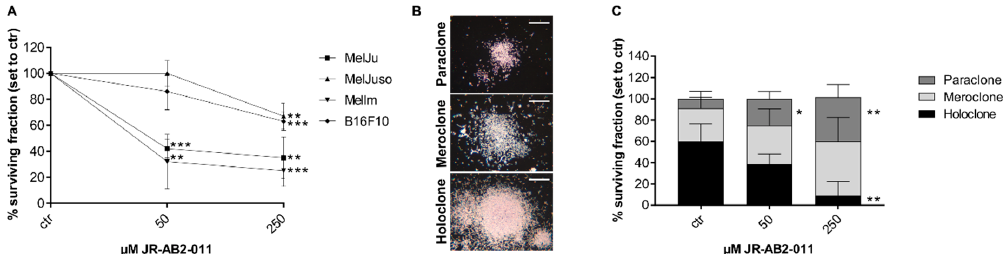
Figure 3. Inhibition of mTORC2 reduced surviving fraction and colony-forming ability. Treatment with JR-AB2-011 (50–250 µM) for 48 h decreased the colony-forming ability significantly in melanoma cells over two weeks in a dose-dependent manner ( p < 0.002) ( A ). Representative images ( B ) show the characteristic morphology of the para-, mero- and holoclones of MelJu. The morphology of the colonies of MelJu altered significantly from the large and rapidly growing holoclone to more miscellaneous meroclones and the small and terminal paraclones in a dose-dependent manner ( p < 0.04) ( C ). Asterisks (* p ≤ 0.05, ** p ≤ 0.01, *** p ≤ 0.001) indicate significance between treatment and control. Scale bar indicates 500 µm.